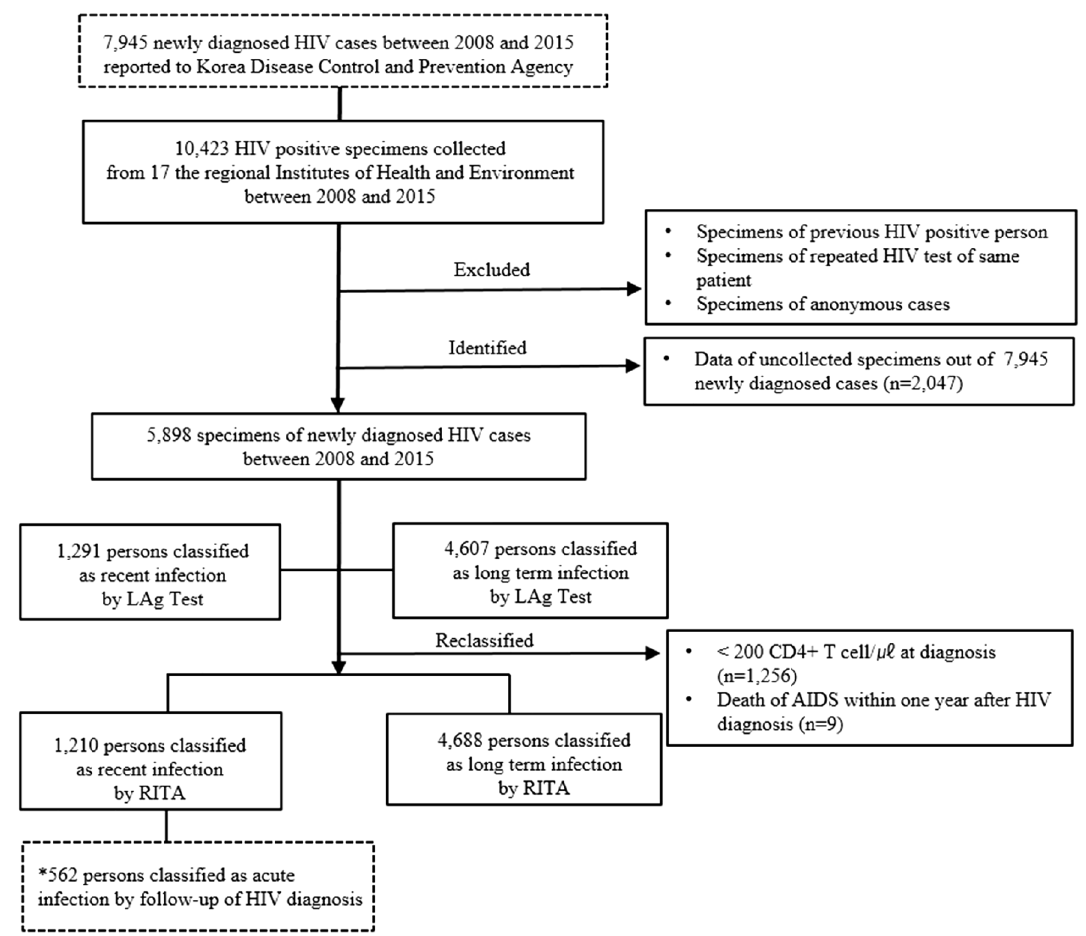
Figure 1. Flowchart for classification as recent and acute HIV infection among HIV-positive specimens from diagnosed infection cases in Korea between 2008 and 2015. Asterisk: 562 persons were identified prior to confirm HIV seroconversion. RITA resent infection testing